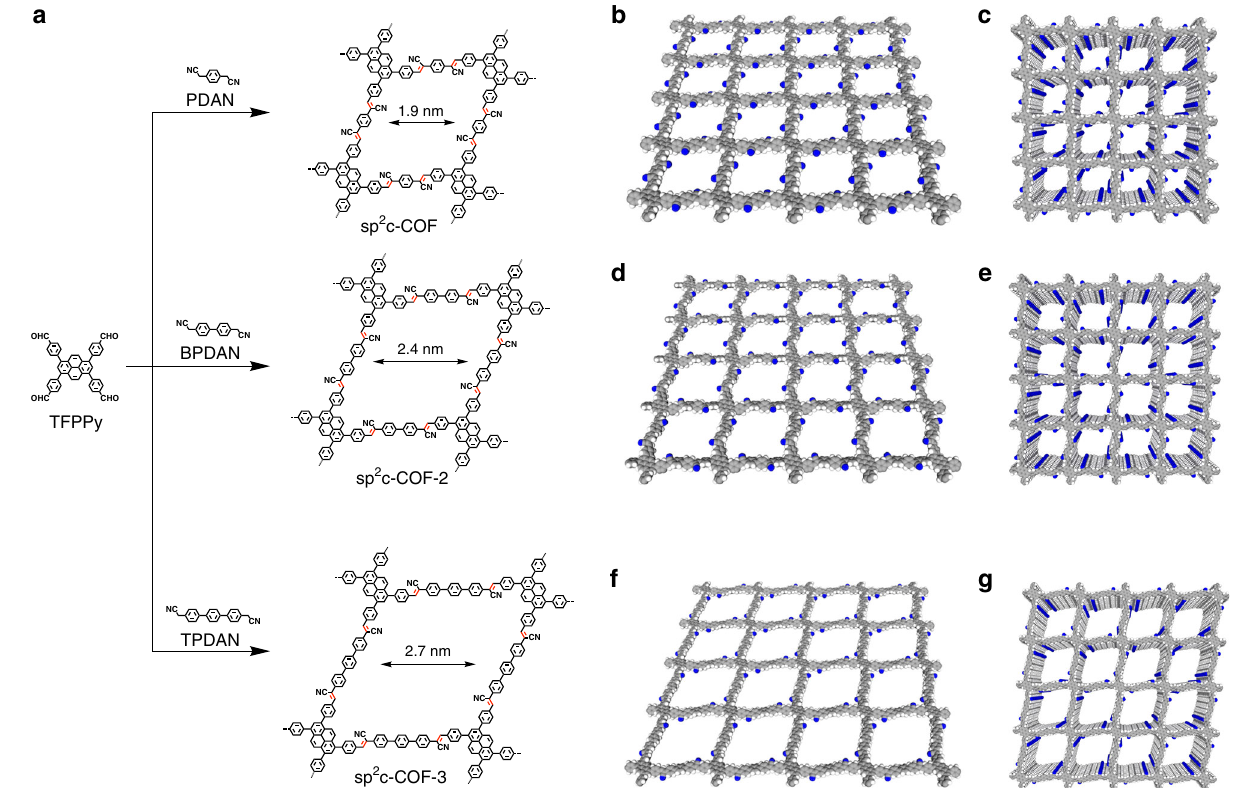
Fig. 1 Design and structures. a Syntheses of sp 2 c-COF through condensation of TFPPy and PDAN, sp 2 c-COF-2 through condensation of TFPPy and BPDAN and sp 2 c-COF-3 through condensation of TFPPy and TPDAN. b Reconstructed crystal structure of single layer of sp 2 c-COF. c Reconstructed crystal structure of many layers of sp 2 c-COF. d Reconstructed crystal structure of single layer of sp 2 c-COF-2. e Reconstructed crystal structure of many layers of sp 2 c-COF-2. f Reconstructed crystal structure of single layer of sp 2 c-COF-3. g Reconstructed crystal structure of many layers of sp 2